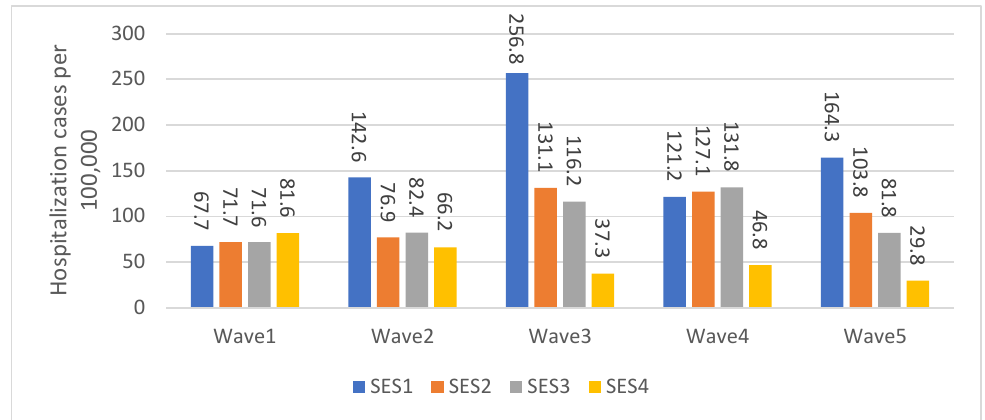
Figure 1. Age-Adjusted Confirmed cases by SES and Waves per 100,000 population. Figure 2 depicts the percentages of hospitalization for the four SES categories for each wave. During the first wave, the proportion of new hospitalizations was the highest among SE cluster 4 (81.6 per 100,000). During the second and third waves, the highest proportion of new hospitalizations was observed among SE cluster 1 (142.6 and 256.8 per 100,000, respectively). The highest proportion of new hospitalizations in the fourth wave occurred among cluster 3 (131.8 per 100,000). During the fifth wave, the highest propor- tion of new hospitalizations occurred among SE clusters 3 and 4.